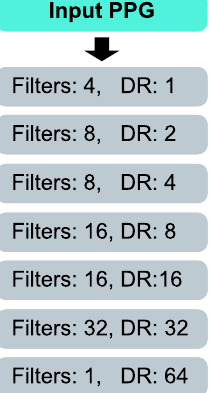
Figure 7. Our model is a fully convolutional neural network with seven layers. Dilatation rate (DR) is doubled at every layer, while the number of filters is slowly increased with depth.